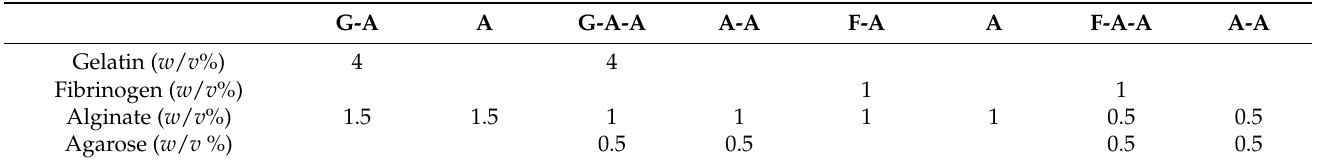
Table 2. Optimum ratio of polymer components in each group.